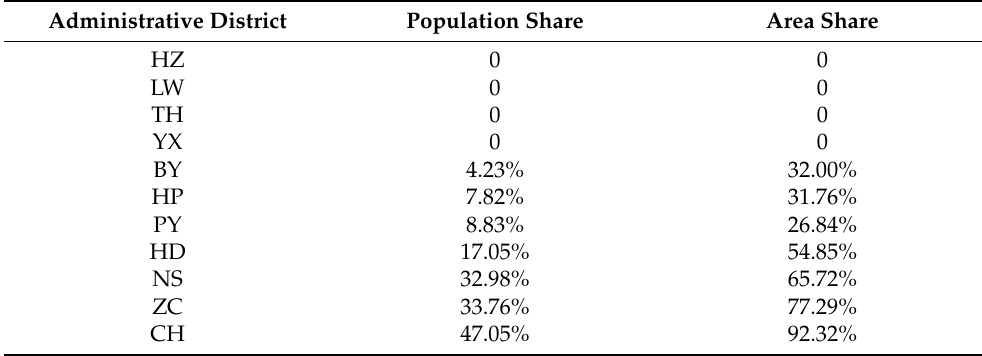
Figure 7. Overall medical accessibility in Guangzhou. Table 3. Percentage of population and area with zero accessibility by district.